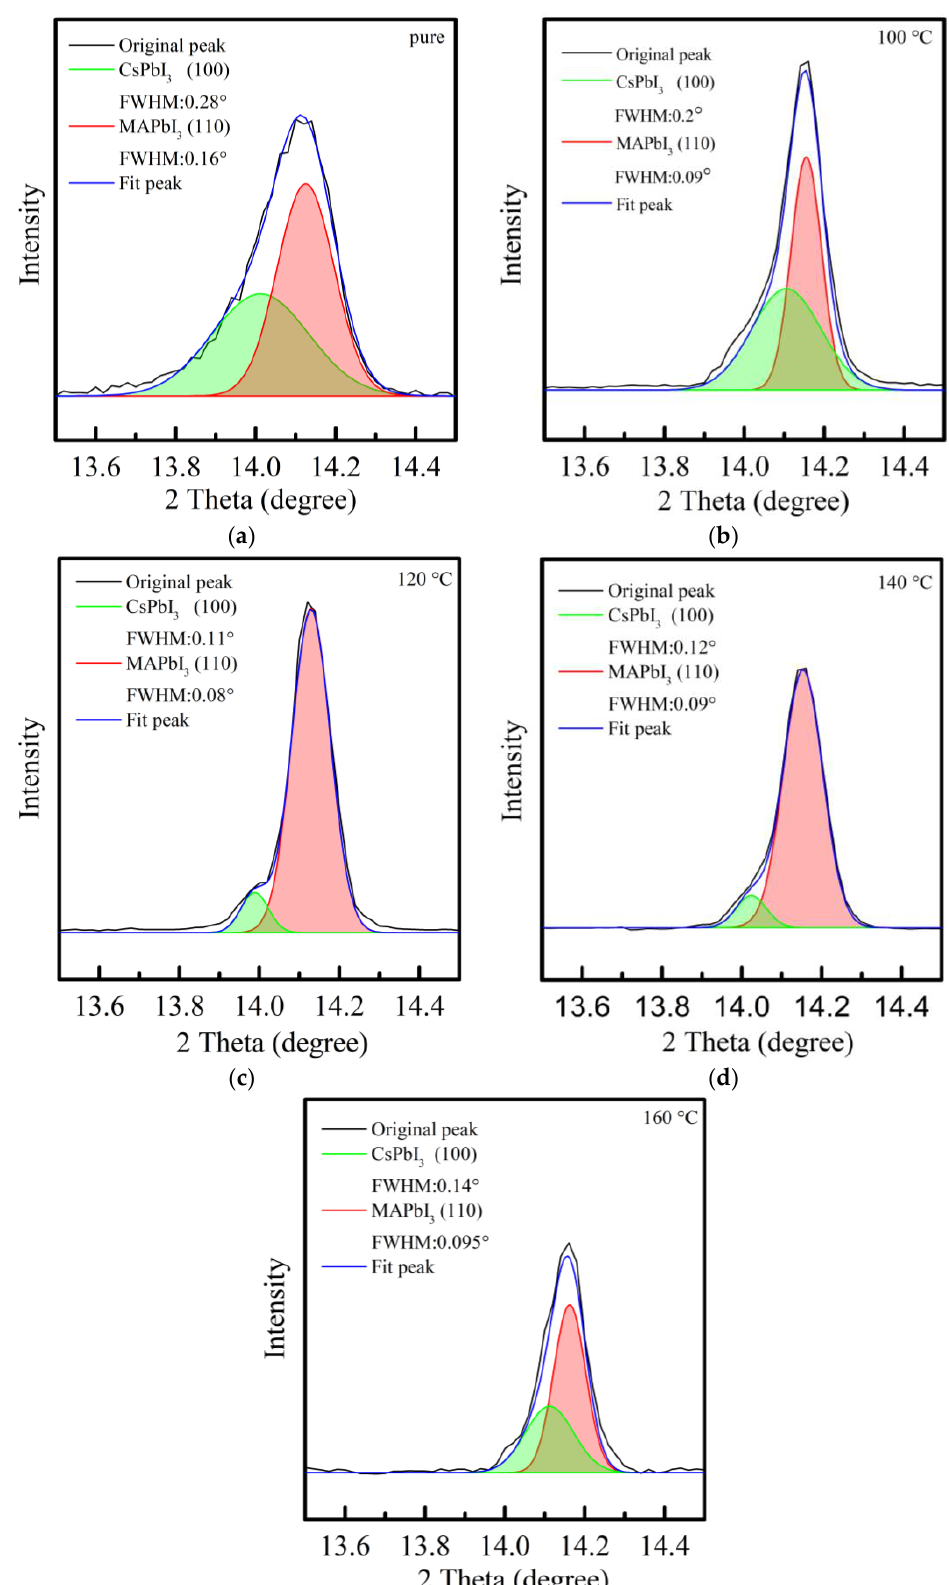
Figure 5. ( a – e ) XRD fitting patterns of PQD films treated at different annealing temperatures.